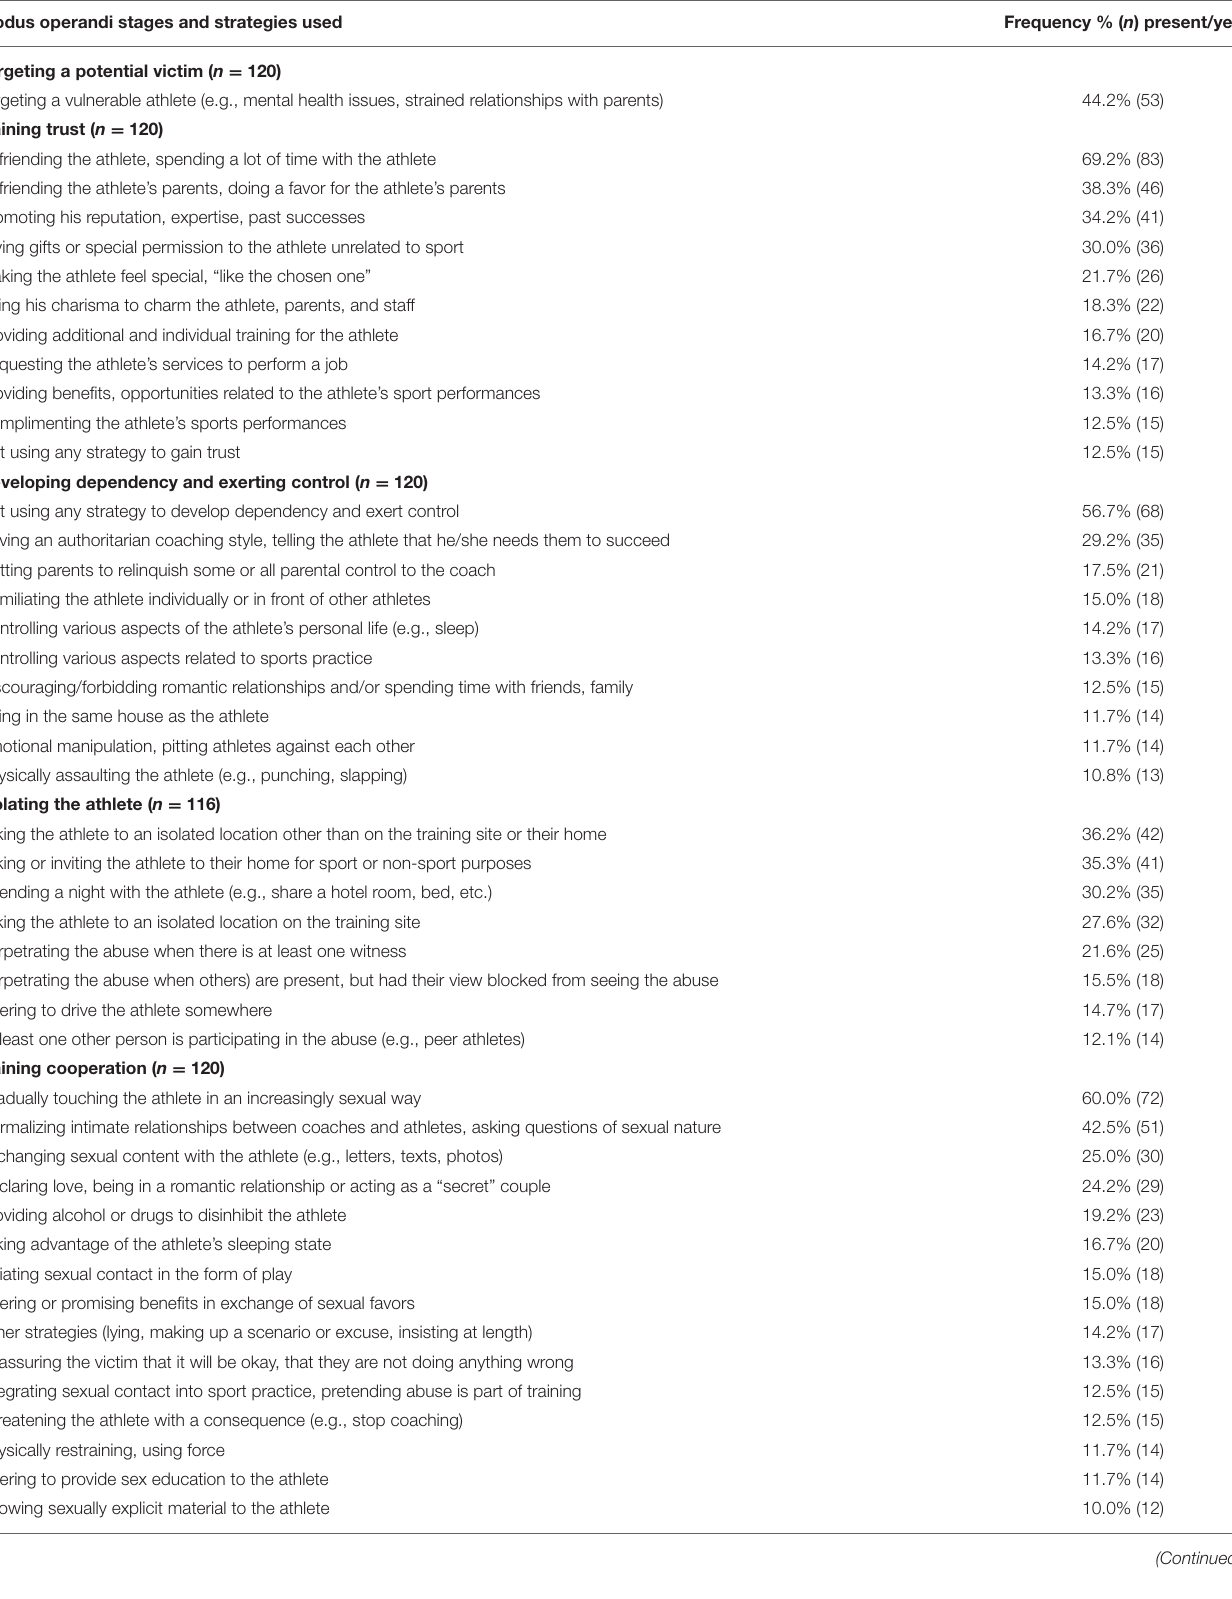
TABLE 2 | Coaches’ modus operandi stages and strategies